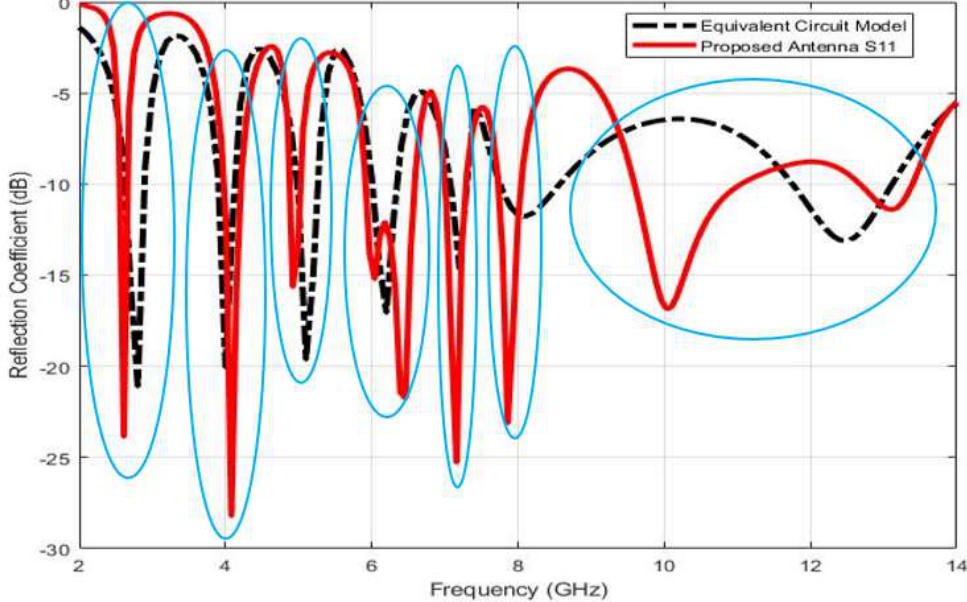
Table 3. Comparison between the simulated and calculated Q and ROC of the proposed antenna.